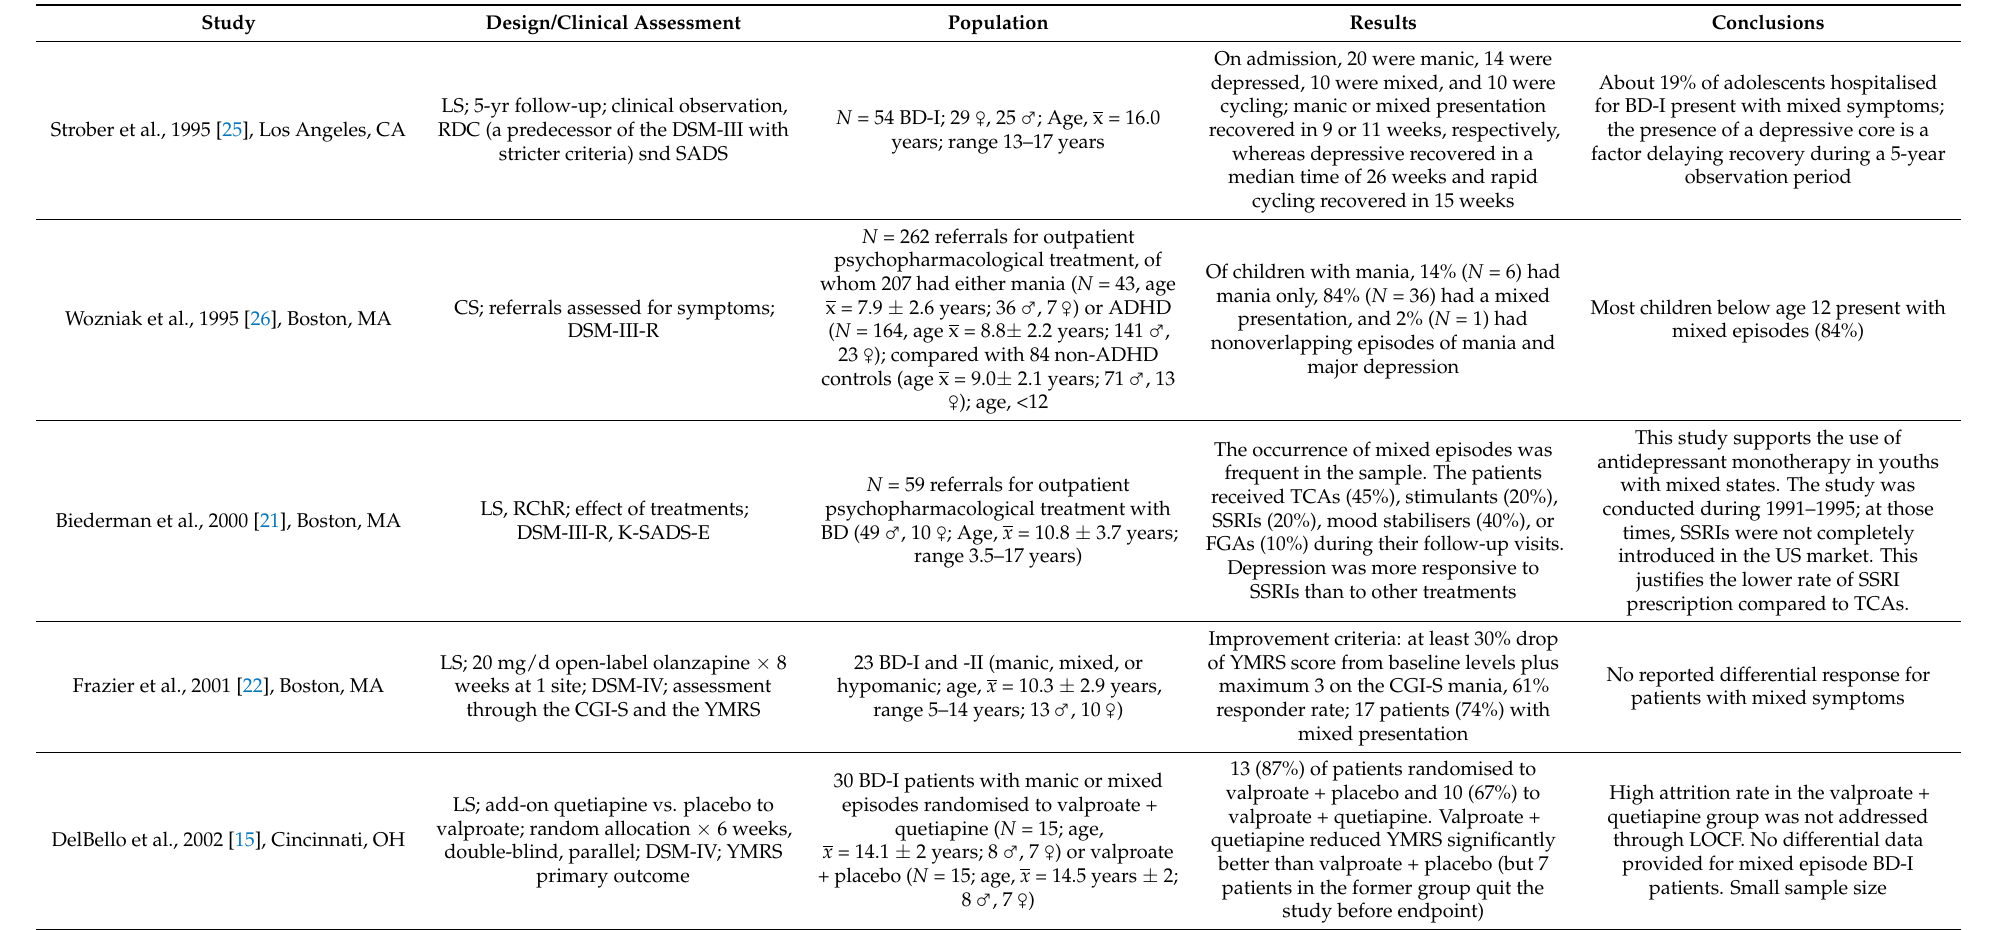
Table 1. Summary of the 11 eligible studies included in this review in order of year of